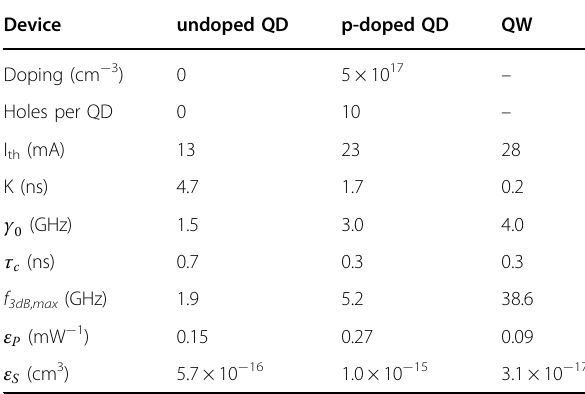
Table 1 Static and dynamic parameters of the undoped QD, p-doped QD, and QW lasers Device undoped QD p-doped